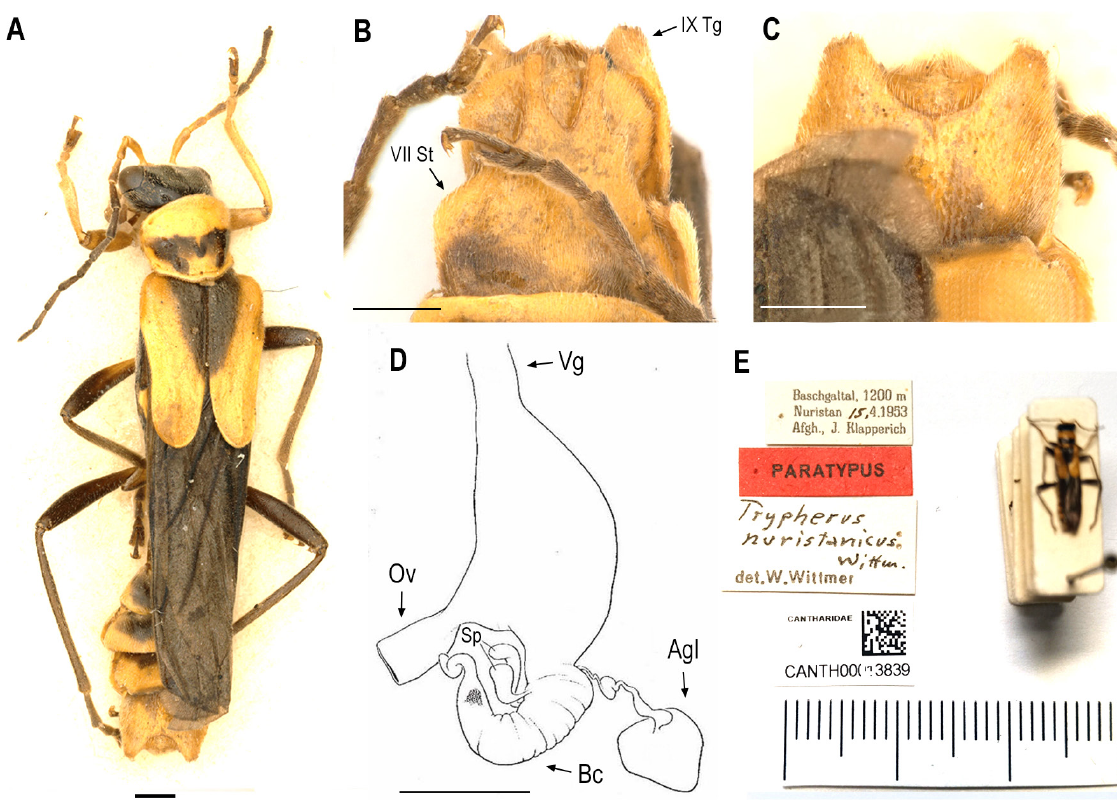
Fig. 7. Trypheridium nuristanicum (Wittmer, 1956) nom. emend., paratype, ♀ (CANTH00013839, NHMB). A . Habitus, dorsal view. B . Terminal segments, ventral view. C . Terminal segments, dorsal view. D . Genitalia. E . Paratype label. Abbreviations: VII St = sternite VII; IX Tg = tergite IX; Agl =